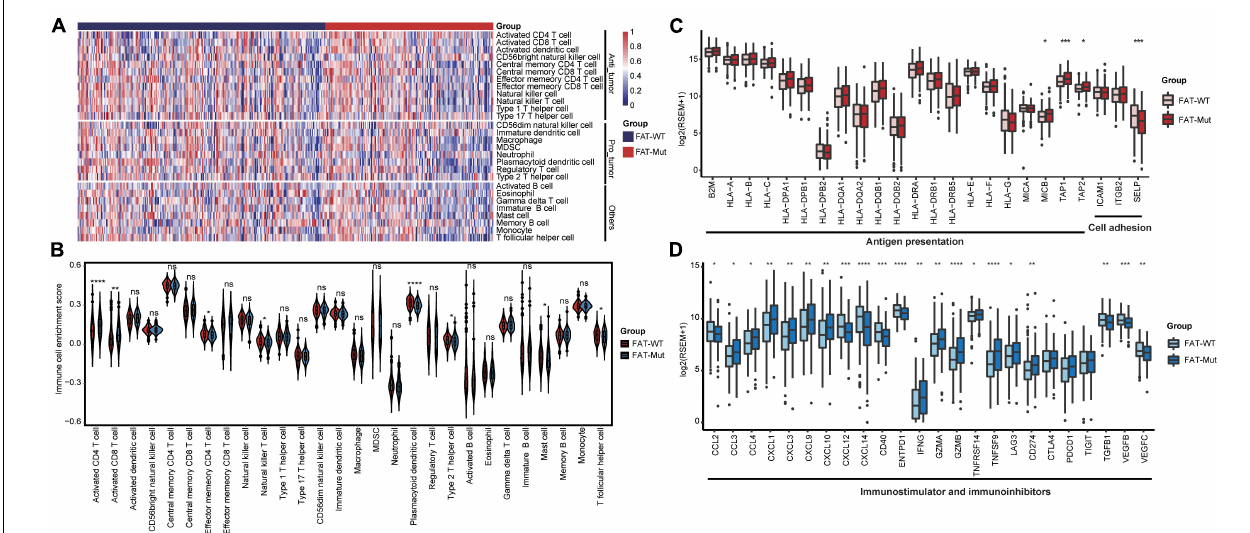
FIGURE 5 | Immune infiltration analysis associated with FAT mutations. (A) The enrichment levels of 28 immune-related cells and types in the FAT-WT and FAT-Mut groups. (B) Comparisons of immune cells between FAT-Mut and FAT-WT patients with STAD. (C,D) The expression levels of immune-related genes, such as antigen presentation, cell adhesion, stimulation, and inhibition in FAT-Mut vs. FAT-WT patients with STAD. All P -values were calculated using the Wilcoxon test, * P < 0.05; ** P < 0.01; *** P < 0.001; and **** P < 0.0001.